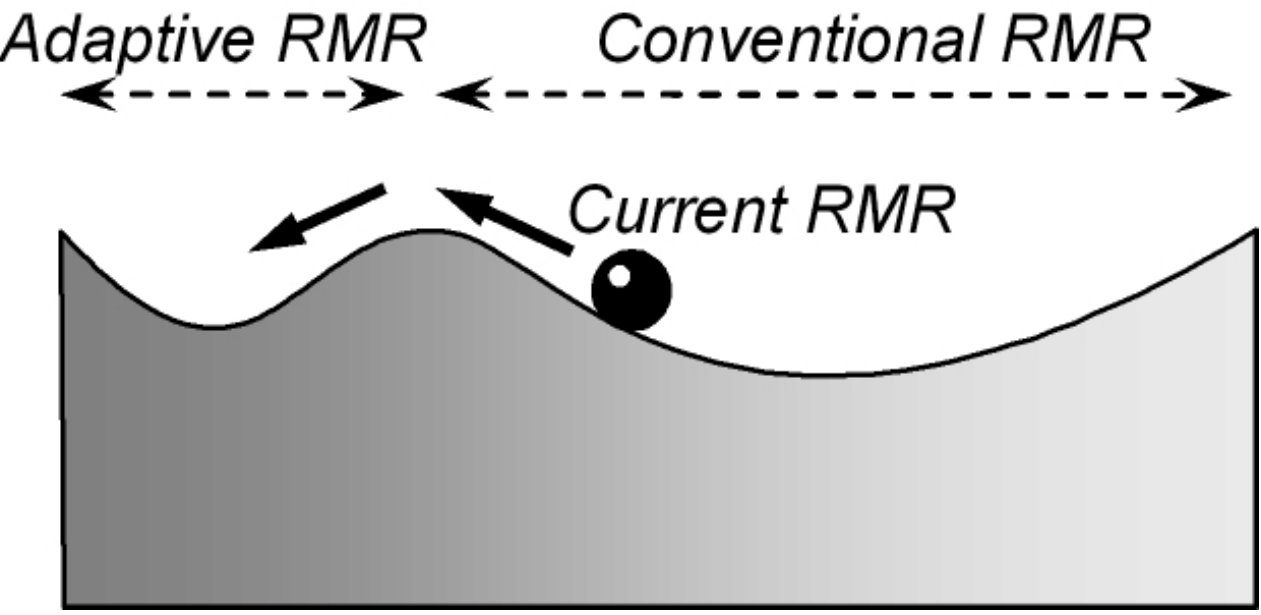
Fig. 3. Alternative management regimes for the Tisza River Basin. Adaptive river management regime (RMR) and Conventional RMR are conceptualized as stability domains. The current RMR, represented by a ball, shows an actual state of the system in